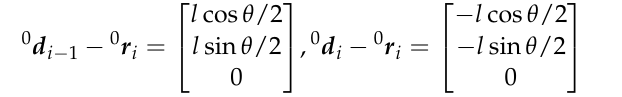
M are the driving and driven moment acting on the link (i); are the external moments acting on the link (i); 0 , d are the global positions of the origin of body frames of link (i), 0 0 1 i I is the rotational inertia around the mass center of link (i), respectively, 0 i angular acceleration of link (i).